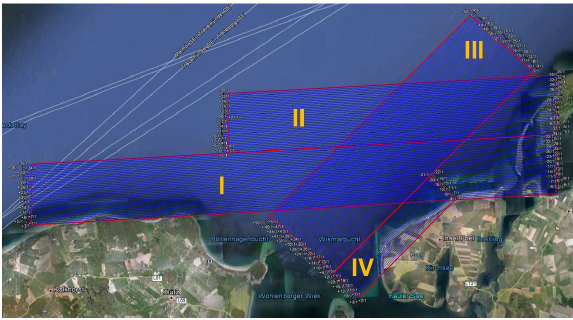
Figure 3: Overview of the four test areas situated close to the island of Poel in the German Baltic Sea.